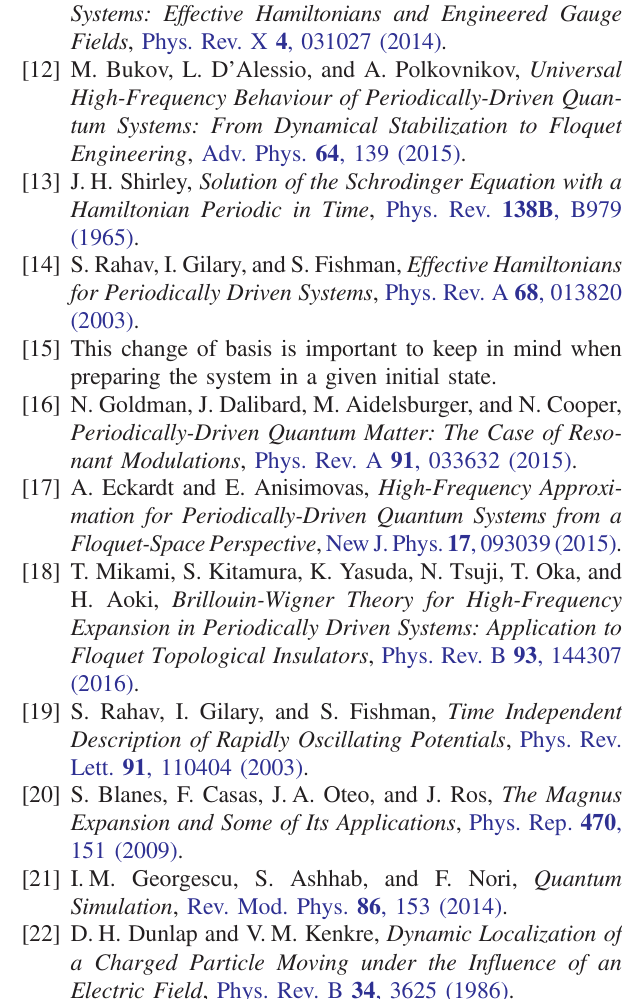
ω Þ vanishes, (left 0 ð K=